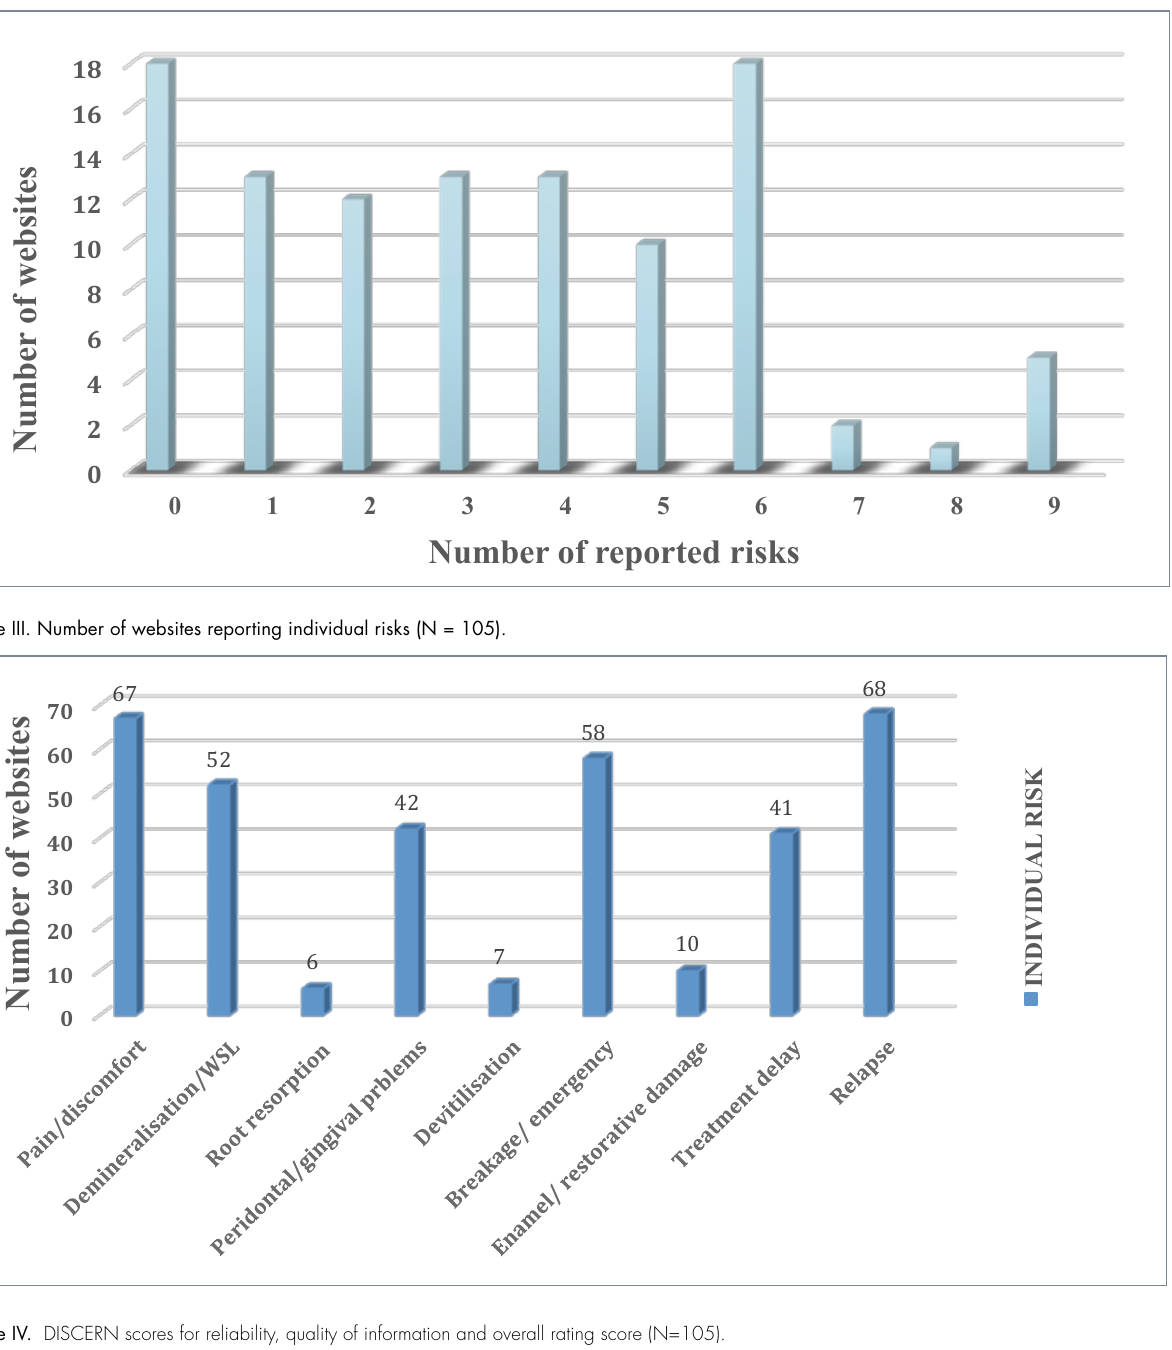
Table II. Number of reported risks per website (N = 105).